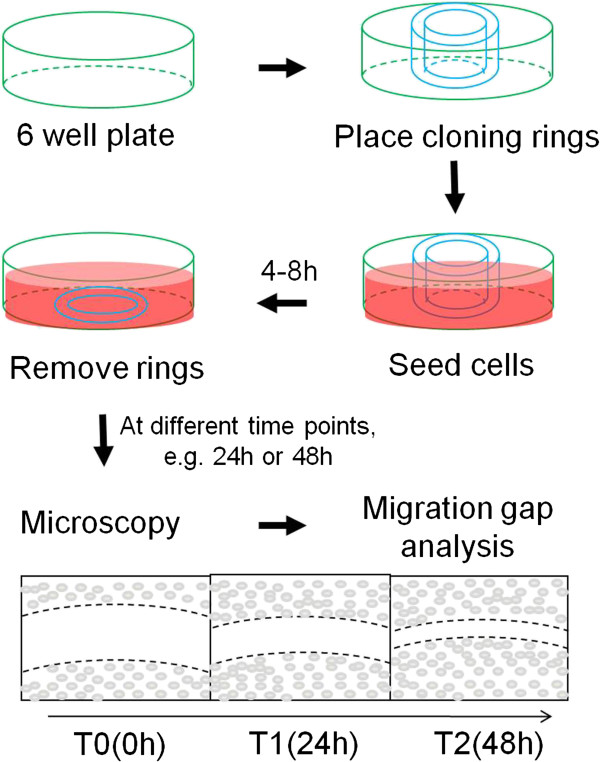
Schematic representation of ring cell migration assay. Cloning rings were used as stoppers after cells were seeded. Removal of rings created ring gaps which allow cells to migrate. The migration of cells was monitored at various time points and the closure rate of the gap was measured to compare the motility of cells.